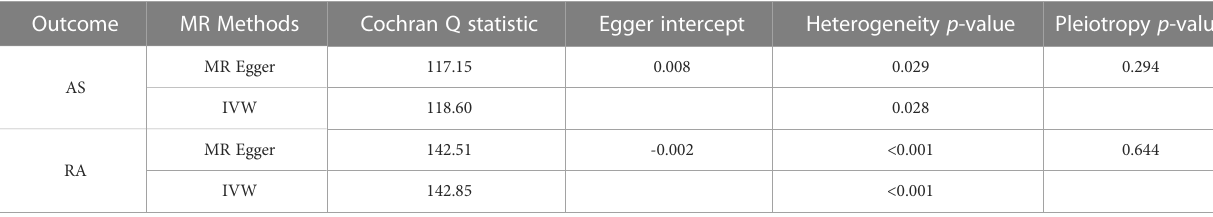
TABLE 2 Heterogeneity and pleiotropy analysis in forward MR